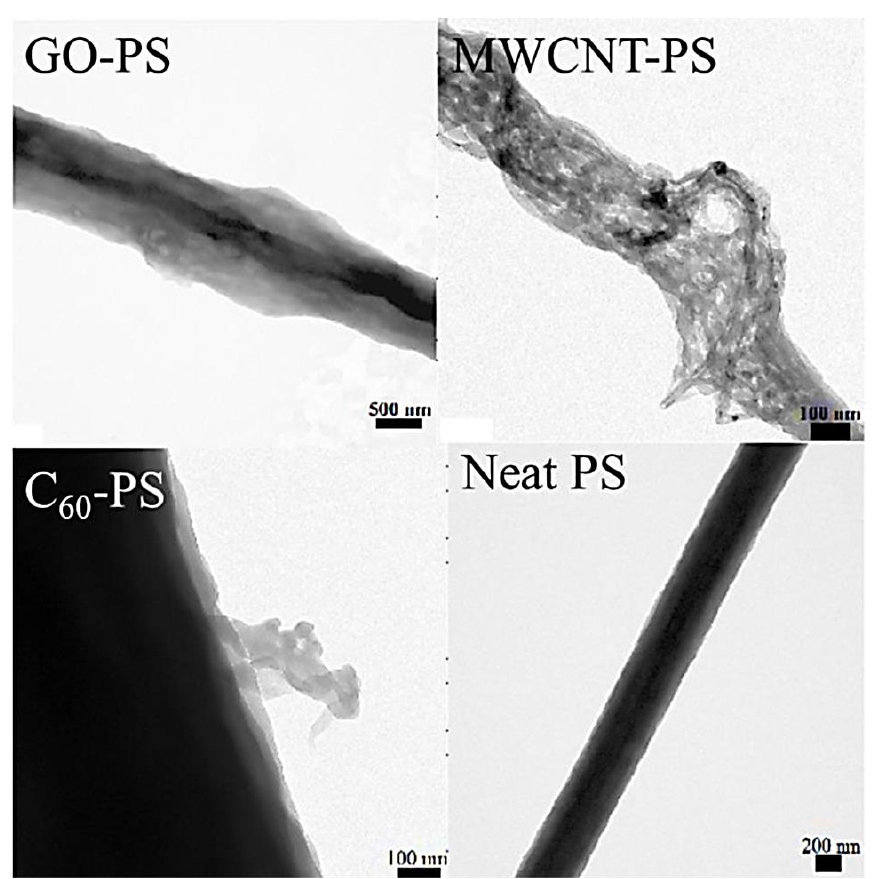
Figure 10. Transmission electron microscopic images of the neat PS and the nanocomposite nano- fiber [188]. PS, polystyrene; C 60 − PS, fullerene − polystyrene; MWCNT − PS, multi-walled carbon nano- tube −polystyrene ; GO − PS, graphene oxide − polystyrene. Reproduced with permission from Else-